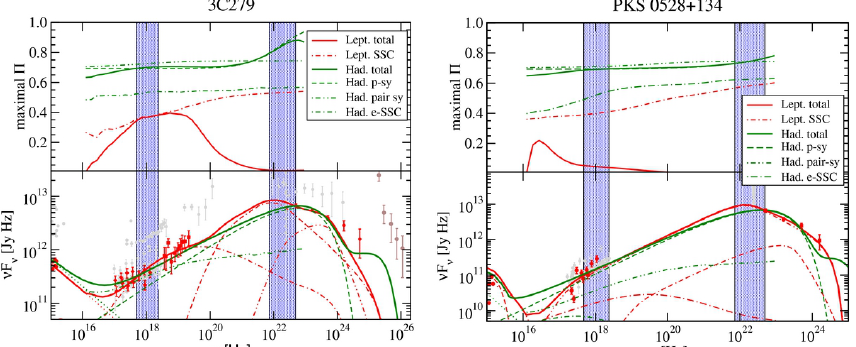
Figure 21. Predictions of X-ray and γ -ray polarization for two FSRQs. Bottom : Zoom-in on the UV– γ -ray SED, based on data from [11] and leptonic (red) and hadronic (green) SED fits from [8]. Top : Predicted high-energy polarization from the SED models of the bottom panel. The vertical shaded bands indicate the 2–10 keV X-ray and and the 30–200 MeV γ -ray band. From [160]. Reproduced with permission from the American Astronomical Society